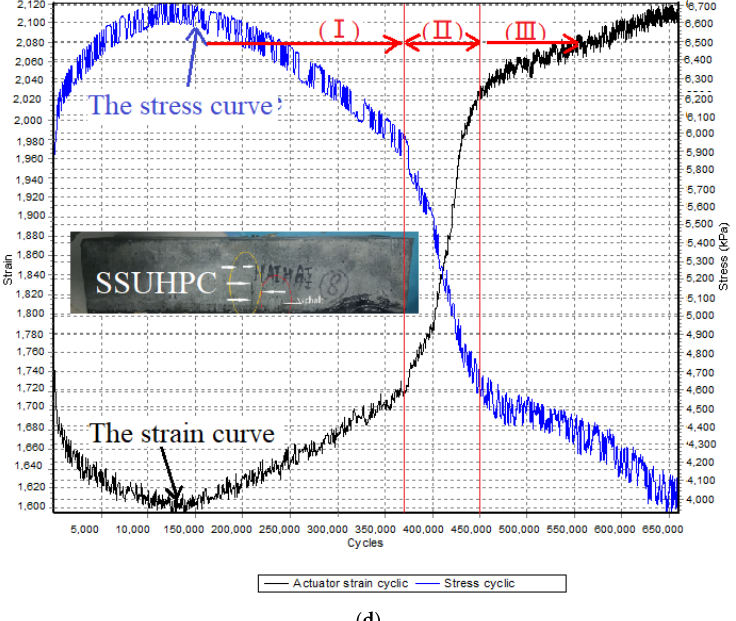
Figure 4. Comparison of stress – strain curves of fatigue tests: ( a ) 1 million loads of FRUHPC when the loading value was 5 kN; ( b ) 1 million loads of SSUHPC when the loading value was 5 kN; ( c ) 500,000 loading times of FRUHPC when the loading value was 10 kN; ( d ) 500,000 loading times of SSUHPC when the loading value was 10 kN.